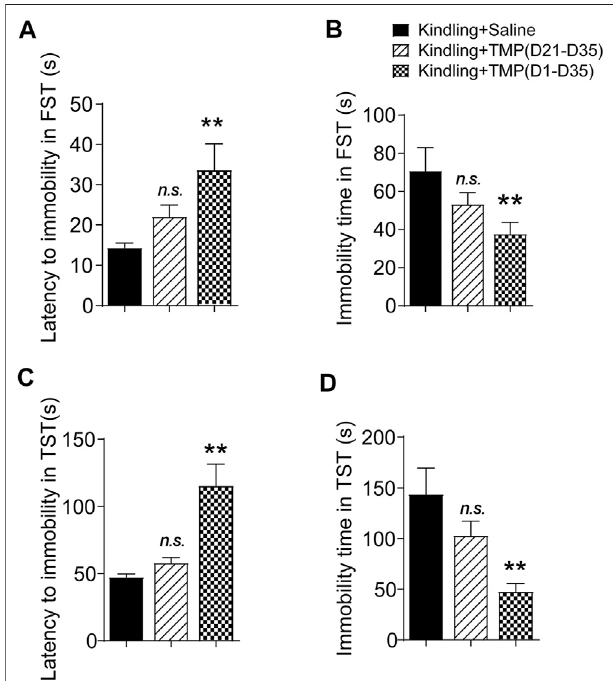
FIGURE 3 | Time dependent effects of TMP on depressive behaviors in late corneal kindling. (A, B) Effects on latency to immobility (A) and total immobility time (B) in FST test with TMP (50 mg/kg, i.p. D21-D35 vs. D1-D35 vs. saline) administration. (C, D) Effects on latency to immobility (C) and total immobilitytime (D) inTSTtest withTMP(50 mg/kg, i.p.D21-D35vs. D1- D35 vs. saline) administration. Statistical analysis was performed by one way ANOVA, followed by Dunnett ’ s multiple comparisons (** p < 0.01, vs. Kindling + Saline).